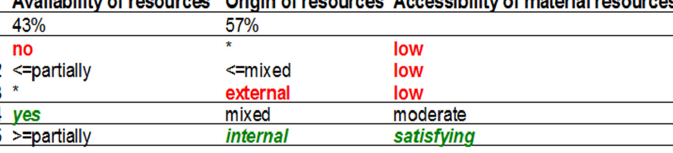
Figure 1. Utility functions of the attribute “Accessibility of material resource”.